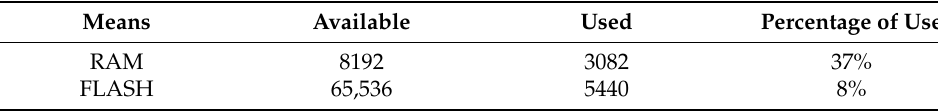
Table 6. Consumption of the microcontroller